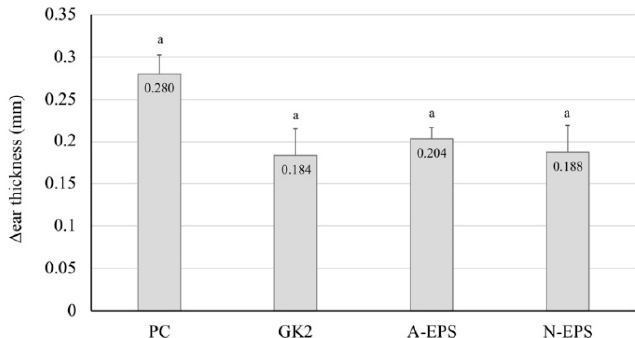
Figure 5. Improvement in PiCl-induced contact dermatitis by application of IJH-SONE68-derived neutral and acidic EPSs to the mouse ear. Ear thickness was measured at 0 h and 24 h after the allergen challenge. A 20- µ L aliquot of each sample (1 mg / mL) was applied to the ear lobe 2 h after the challenge. Data are indicated by mean ± S.D. of 5 mice. Abbreviations used in the figure: PC, positive control (without treatment); GK2, dipotassium glycyrrhizinate (1 mg / mL); A-EPS, acidic EPS (1 mg / mL); N-EPS-1, neutral EPS (1 mg / mL). Di ff erent characters described on the top of the bars indicate statistically significant di ff erences between means of values obtained in di ff erent group (the Tukey–Kramer test, p < 0.05).